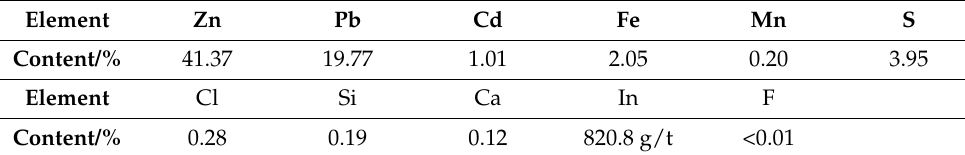
Table 1. The chemical composition of the ZOD sample (mass fraction,